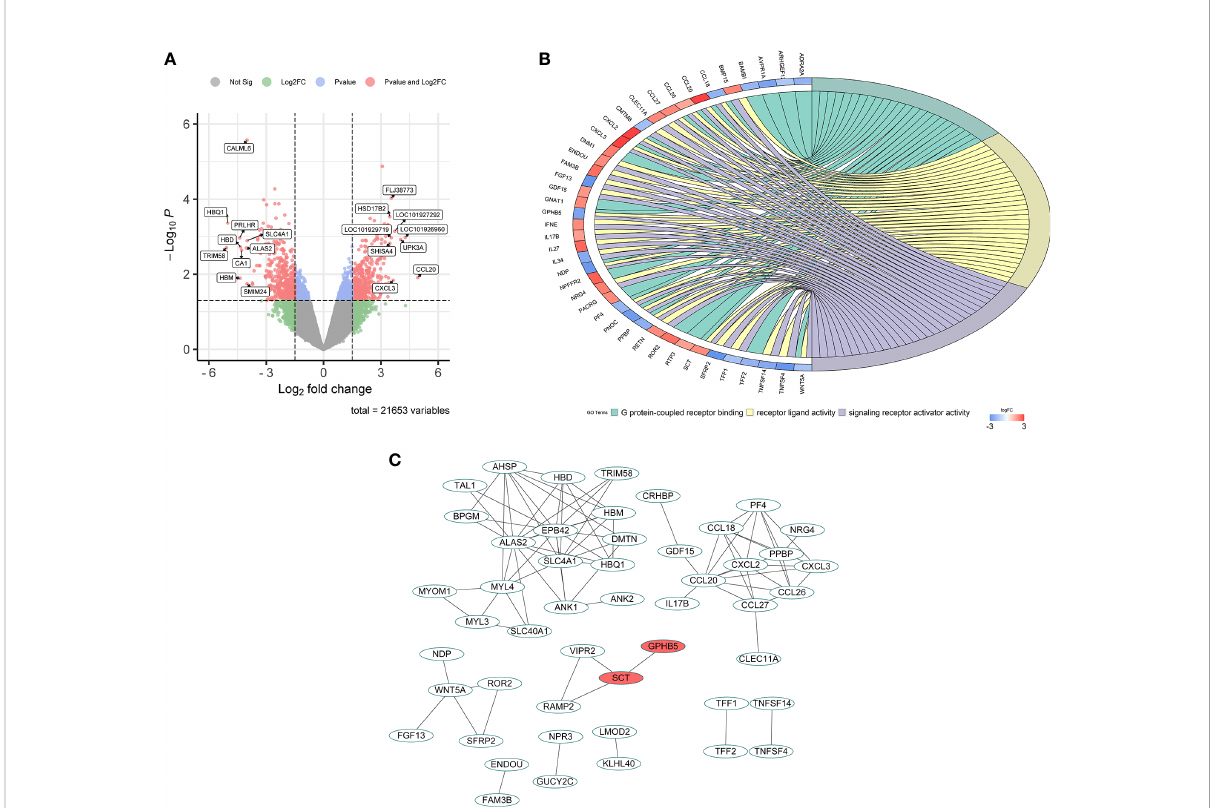
FIGURE 2 Bioinformatic analysis for GPHB5 related genes and signaling pathways in PCOS individuals. (A) Volcano map of DEGs for GPHB5 high expression and low expression. (B) GO enrichment analysis of DEGs. (C) PPI network of